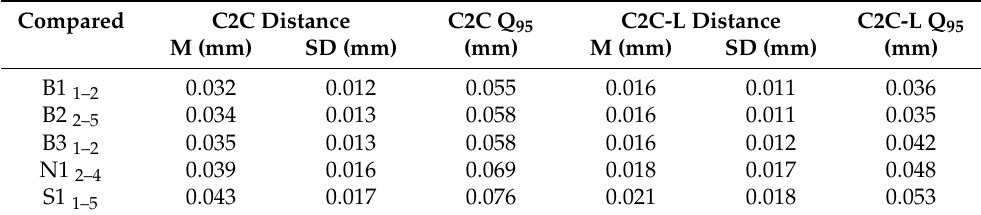
Table 5. Average distances (M) and standard deviations (SD) of selected C2C and C2C-L local distance comparison (from 2D1/2 triangulation model): B1 1–2 = compared points cloud 1 and 2, . . . , S1 1–5 = compared points cloud 1 and